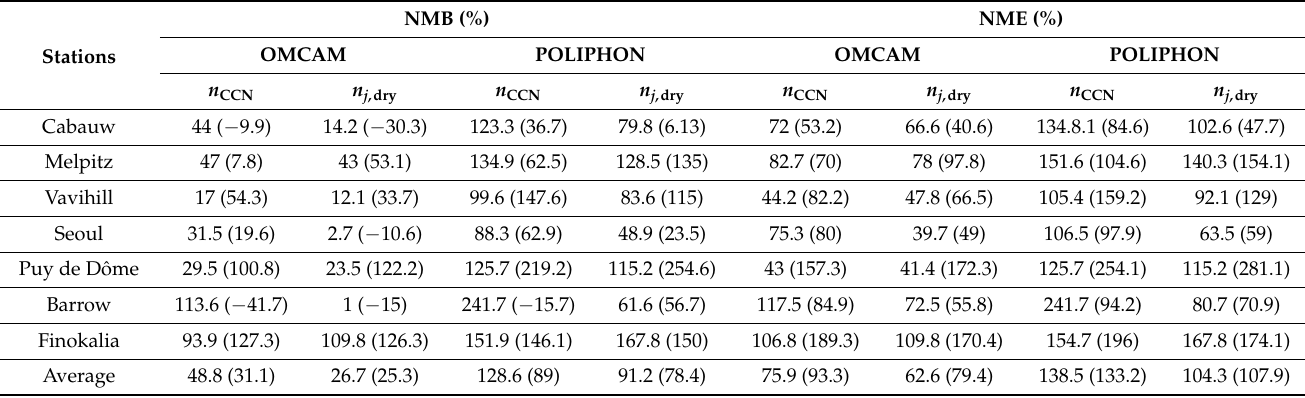
Table 3. Comparison statistics of monthly n CCN at ss = 0.2% (in cm − 3 ) and n j ,dry (in cm − 3 ) derived from in situ and CALIOP measurements. The values enclosed within brackets are for daytime CALIOP retrievals and the unbracketed values represent nighttime retrievals. The normalized mean bias (NMB) and normalized mean error (NME) are given along with their averages weighted by the number of observation months for each